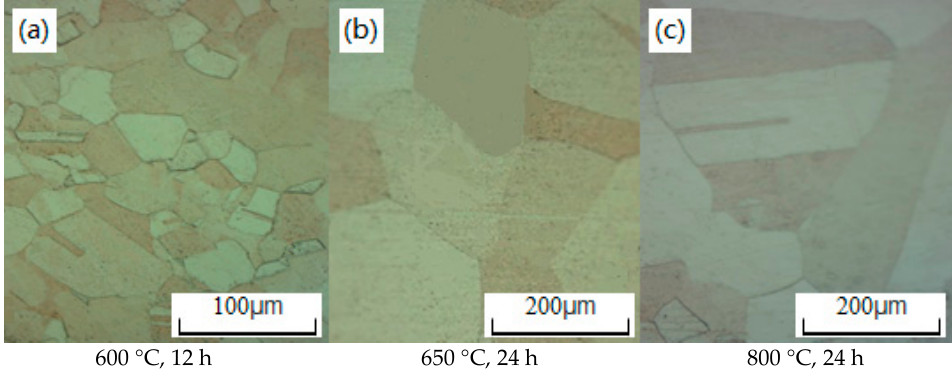
Figure 3. Microscopic microstructure of heat-treated specimen with different grain sizes. Metals 2019 , 9 , x FOR PEER REVIEW